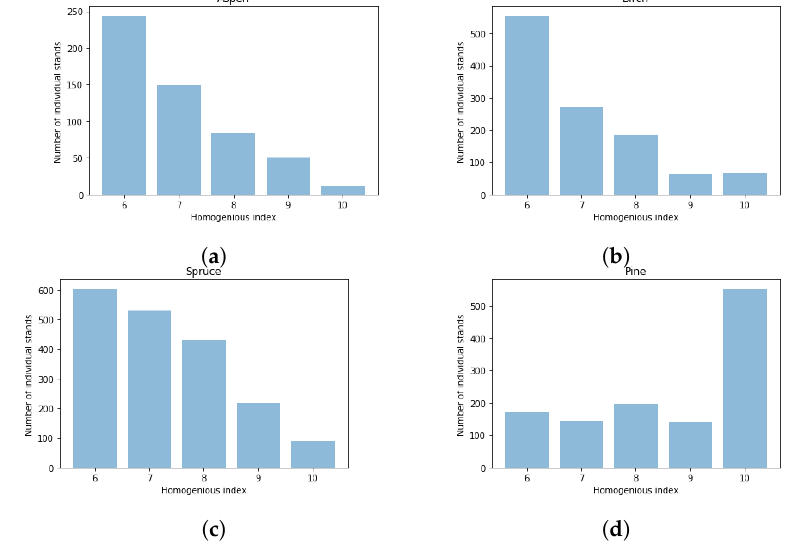
Figure 3. Distribution of